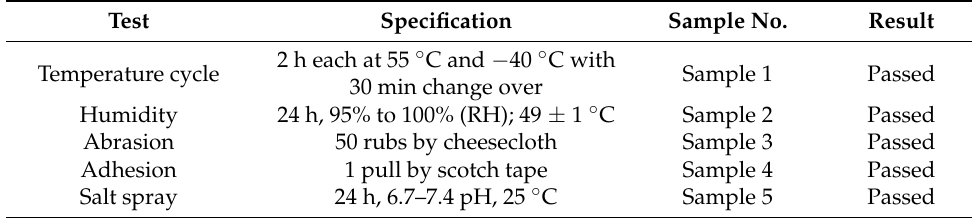
Figure 11. Pictures of sample 1 taken by camera before and after the environmental stability test, ( a ) before and ( b ) after the experiment. Table 1. Durability and environmental tests (as per